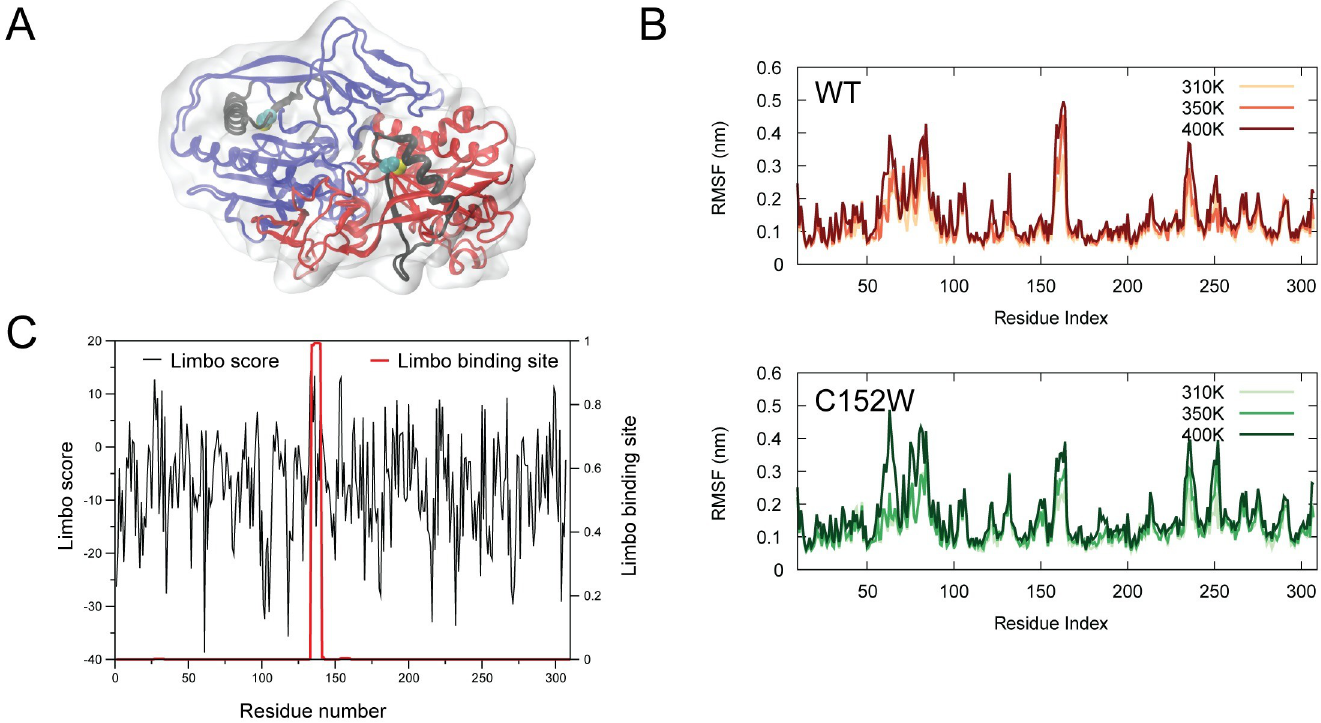
Fig 3. ASPA C152W is not globally destabilized and might instead transiently expose a buried degron. (A) Structure of the ASPA dimer (PDB ID 2O53) with monomers shown in red and blue. Residues 133–160, that include a putative degron, are coloured in black, and the C α and heavy atoms in the side chain of C152 are shown as spheres. The protein structure is visualized with PyMOL [50] and VMD [51]. (B) We calculated the root mean square fluctuations (RMSF) of the C α atoms during MD simulations of (top) wild-type and (bottom) C152W ASPA at three temperatures. The RMSF values were averaged over the results of the two monomers. (C) We used Limbo [52] to predict putative DnaK (Hsp70) binding sites in the ASPA sequence, and show both (black) the raw binding scores (over seven residue peptides) and (red) a “Boltzmann” probability to highlight the most likely binding sites.